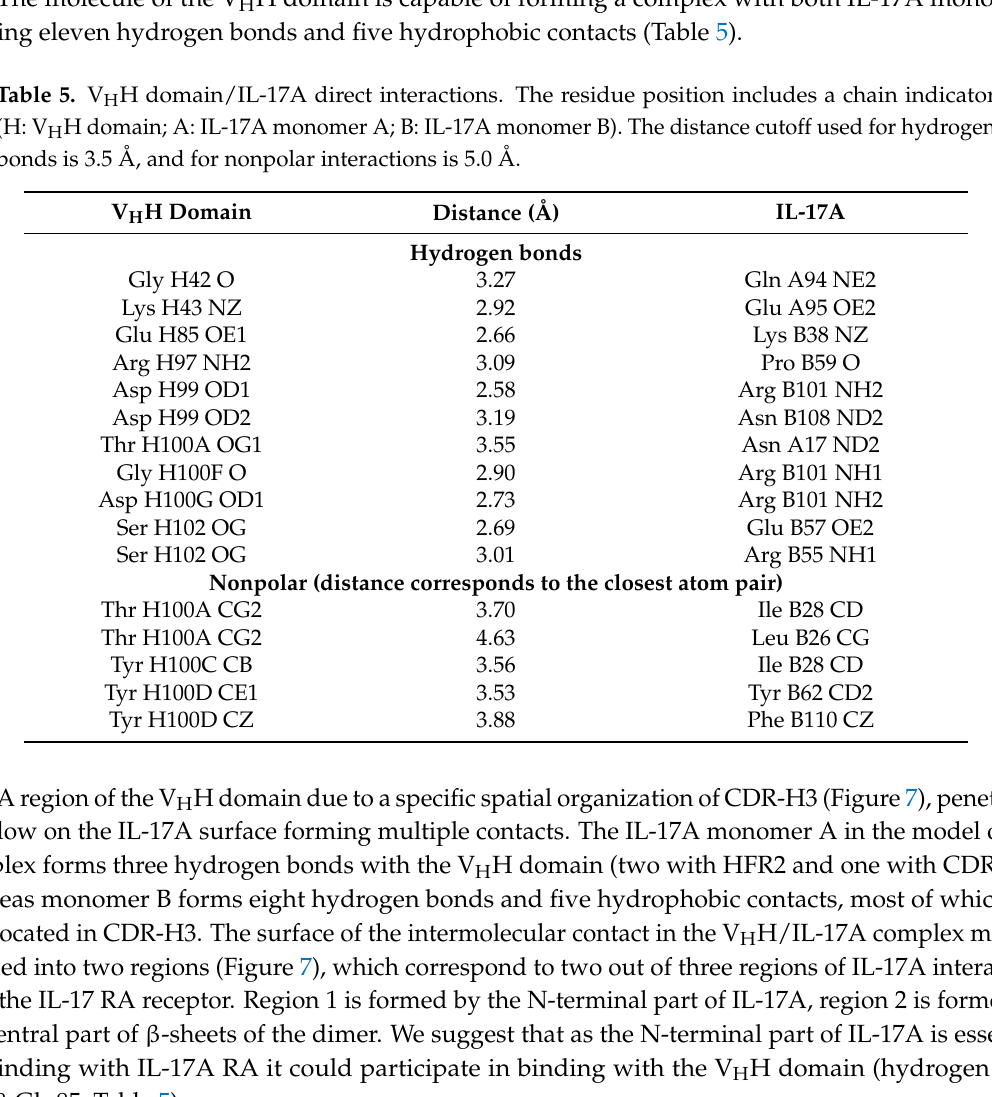
Table 5. V H H domain/IL-17A direct interactions. The residue position includes a chain indicator (H: V H H domain; A: IL-17A monomer A; B: IL-17A monomer B). The distance cutoff used for hydrogen bonds is 3.5 Å, and for nonpolar interactions is 5.0 Å. V H H Domain Distance (Å) IL-17A